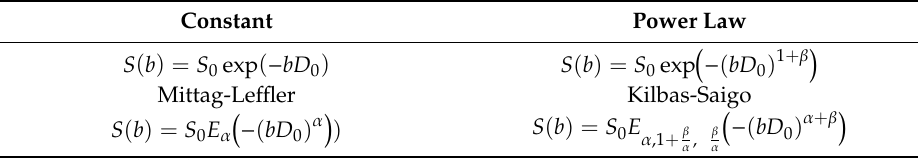
Table 1. Summary of Diffusion Decay functions, S(b) , for Selected Cases.